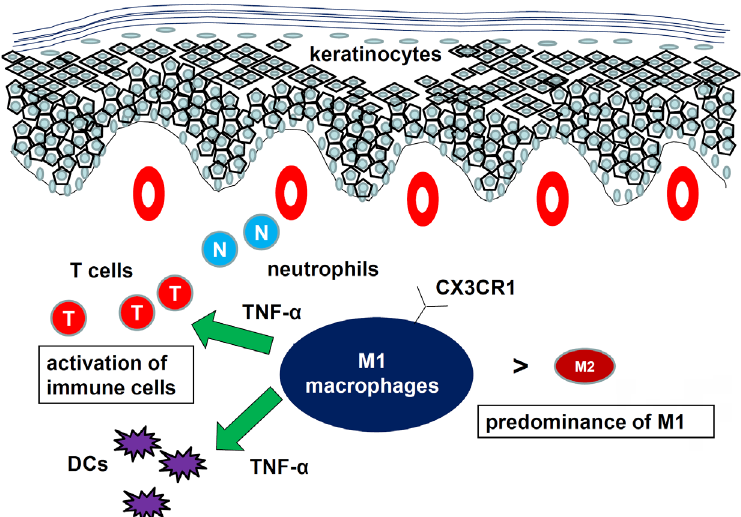
Figure 2. Role of macrophages in psoriasis. The ratio of M1/M2 macrophages is increased. Macrophages produced proinflammatory cytokines to develop